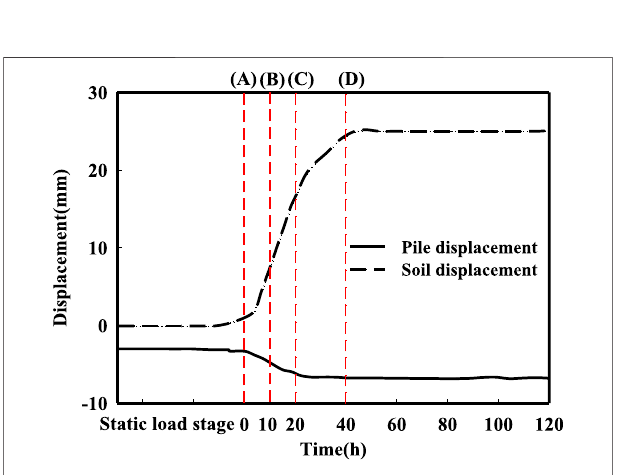
FIGURE 5 | Variations of volumetric water content distribution with the time of